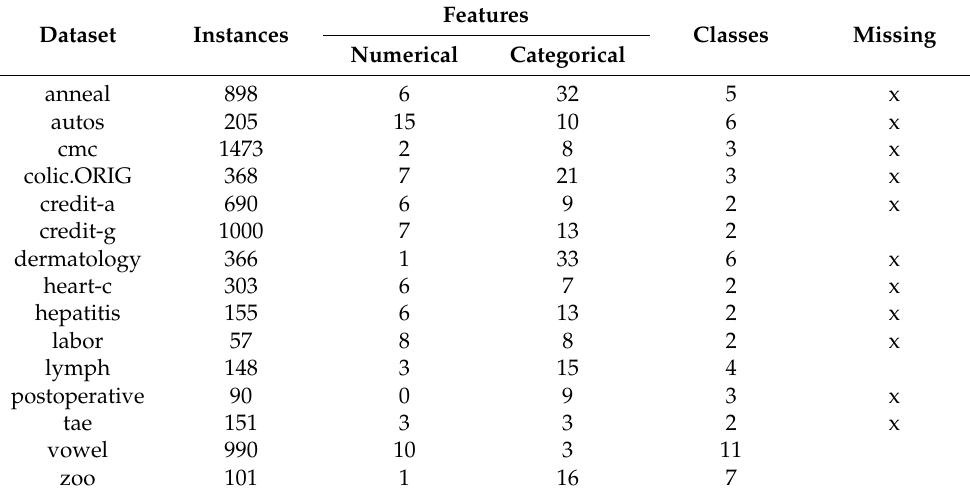
Table 1. Description of the datasets used in the numerical experiments.